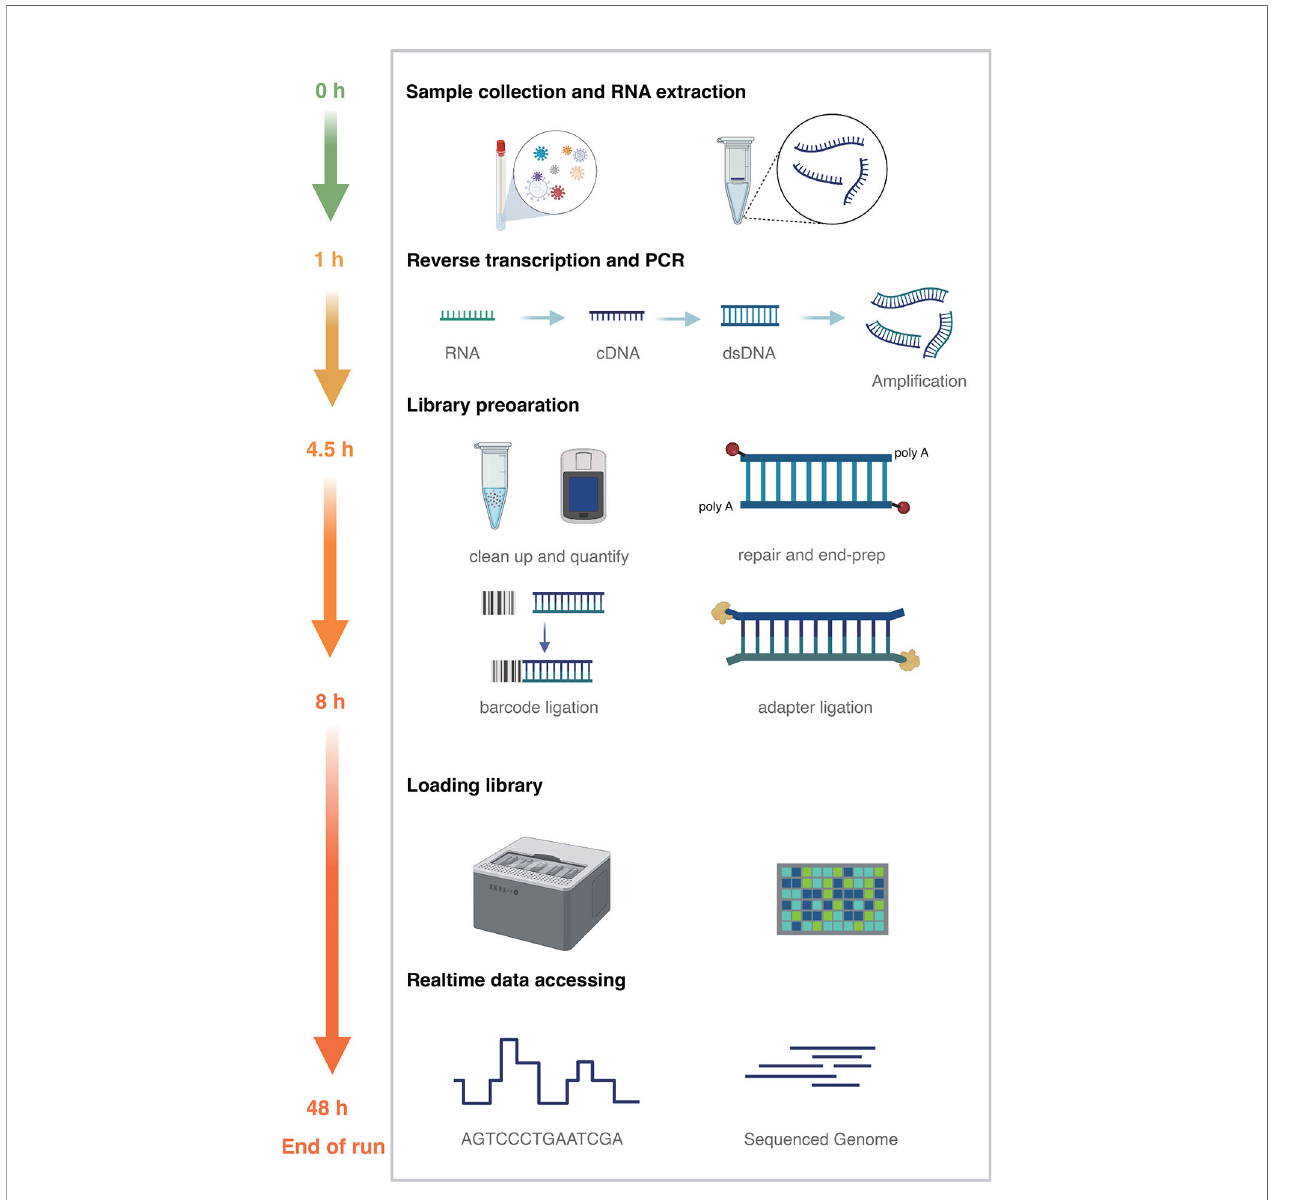
FIGURE 1 | Nanopore metatranscriptomic sequencing method time frame diagram. Sample collection and RNA extraction (green, 1 hour); reverse transcription, second-strand synthesis and PCR (yellow, 3.5 hours); library construction (orange, 3.5 hours); library loading, sequencing, real-time data analysis to end of sequencing (till 48